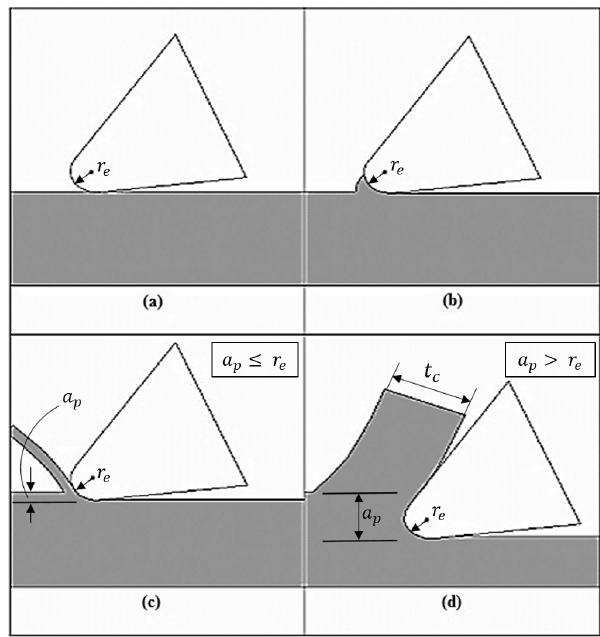
Figure 2. Micro-milling tool workpiece interaction (adapted from Jaffery et al.,